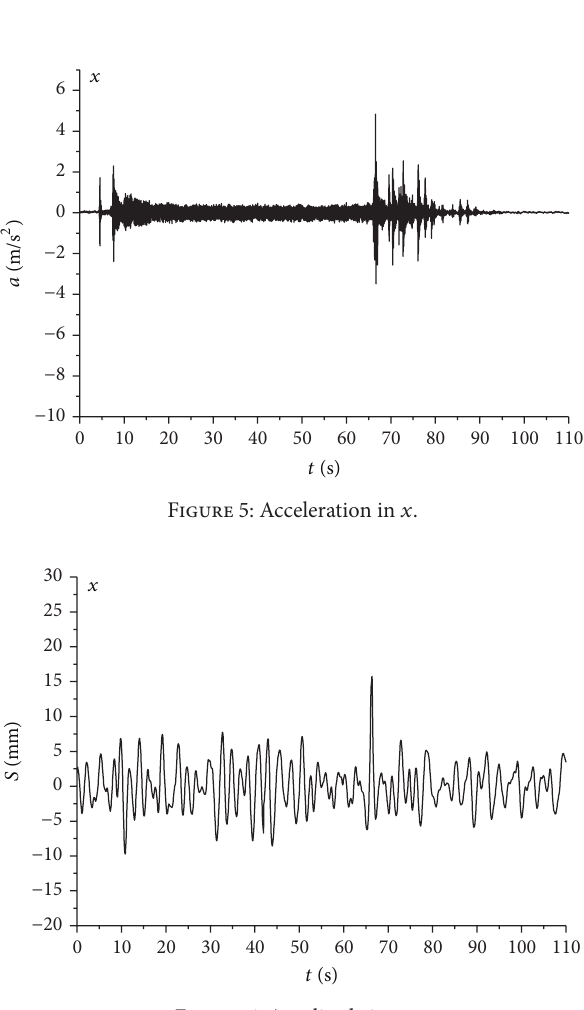
Figure 6: Amplitude in 𝑥